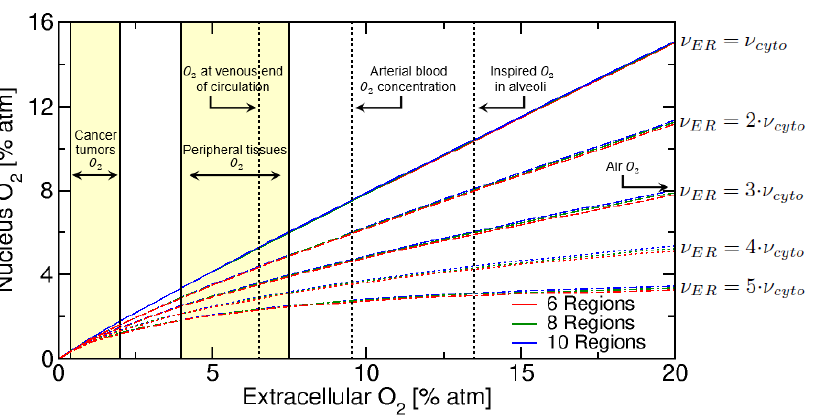
Figure 4. Nuclear oxygen versus extracellular oxygen, for 6, 8 and 10 total regions, representing an increasing number of ER regions and membranes. Oxygen vertical lines and yellow regions are taken from McKeown (2014) [50].